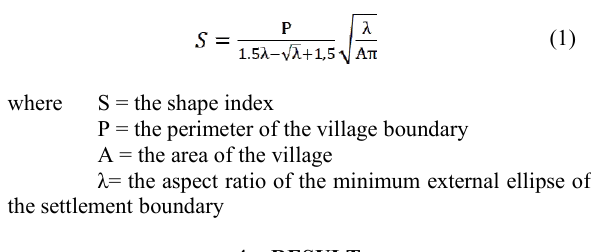
Table 1 . Performance of two models with the same test dataset.